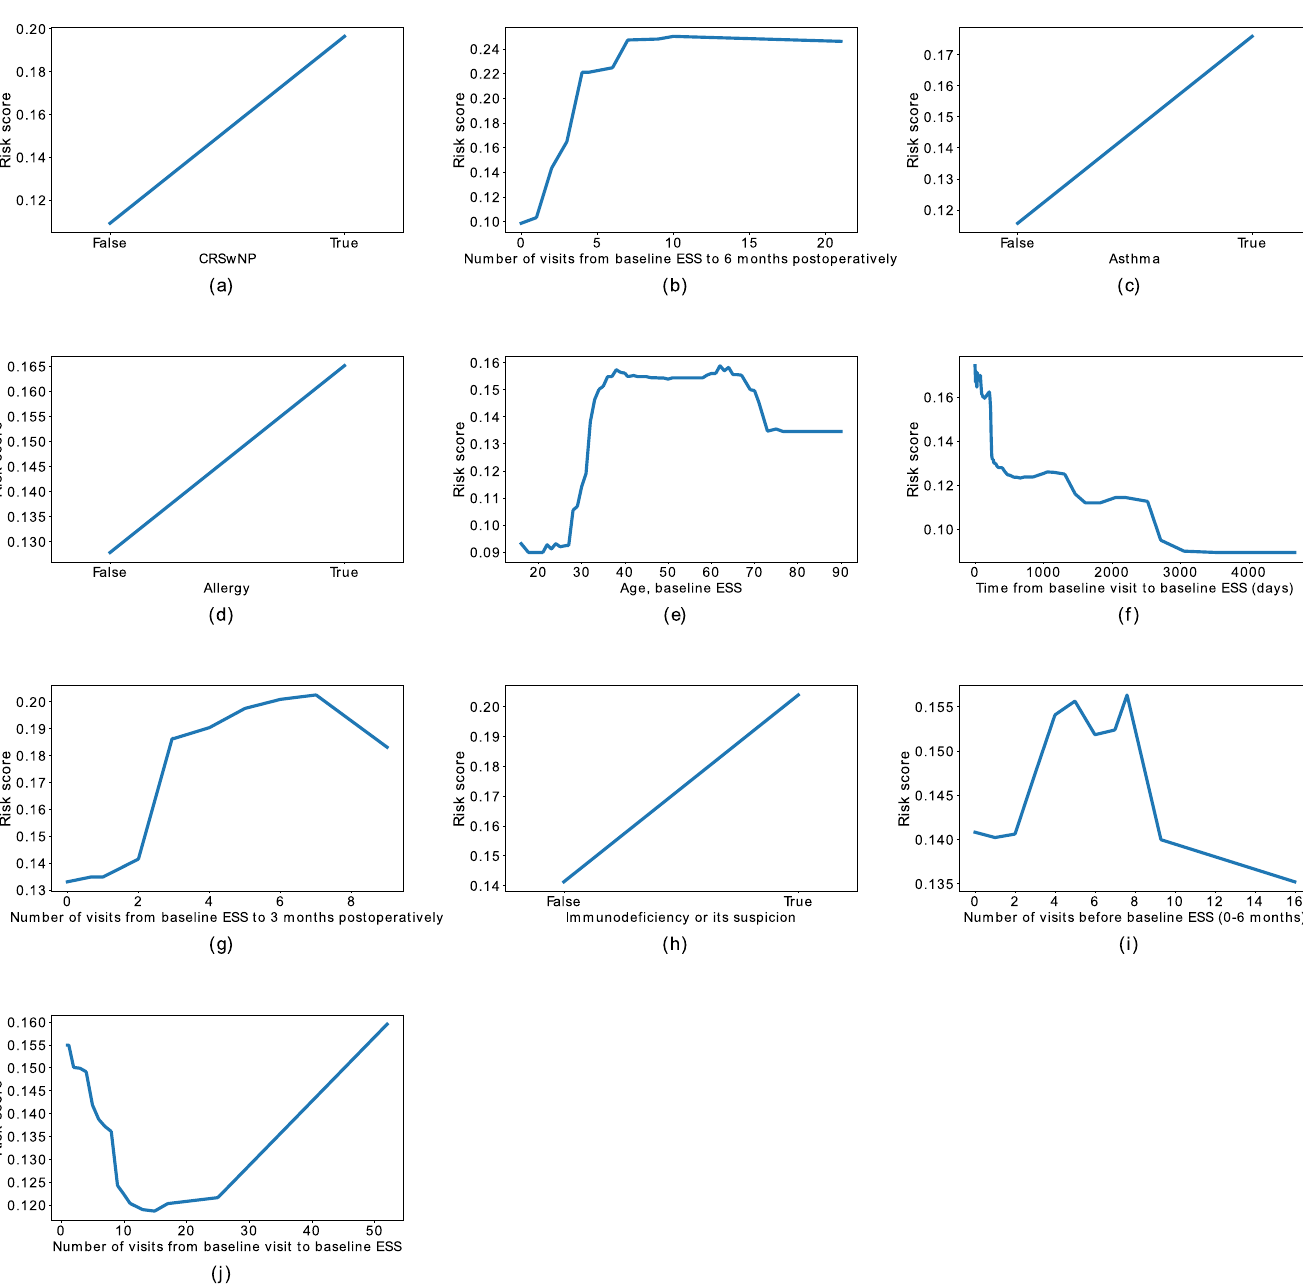
PLOS ONE | https://doi.org/10.1371/journal.pone.0267146 April 29,